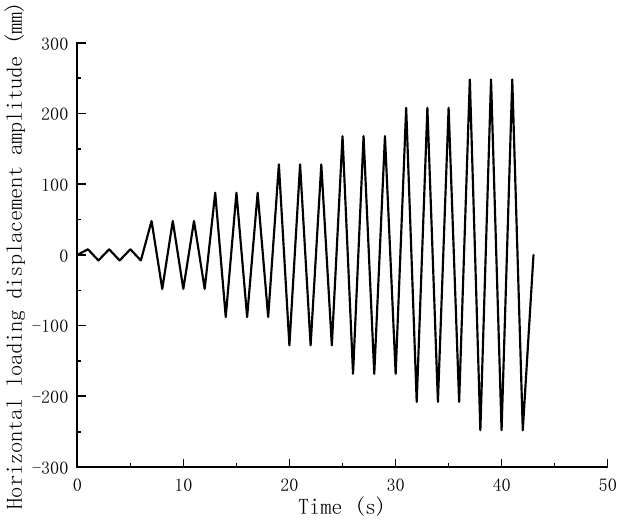
Figure 17. Horizontal displacement loading system.